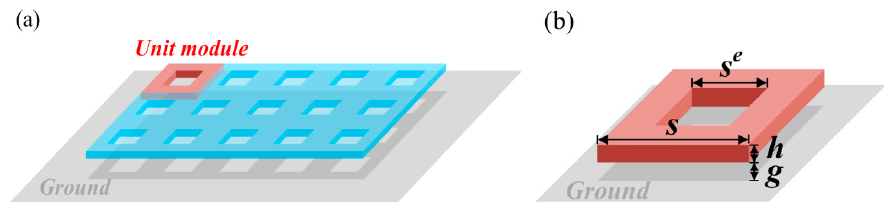
Figure 3. ( a ) Schematic diagram of the capacitive structure with etching holes; ( b ) Schematic diagram of the unit module. s : The length of unit module; s e : The length of etching hole.